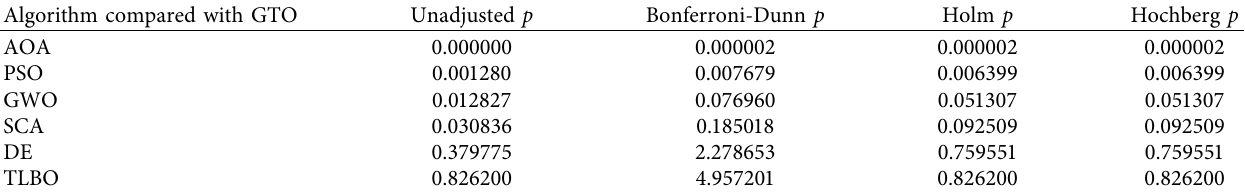
Table 13: Post hoc analyses for the multiple comparison between GTO and its peer algorithms. Algorithm compared with